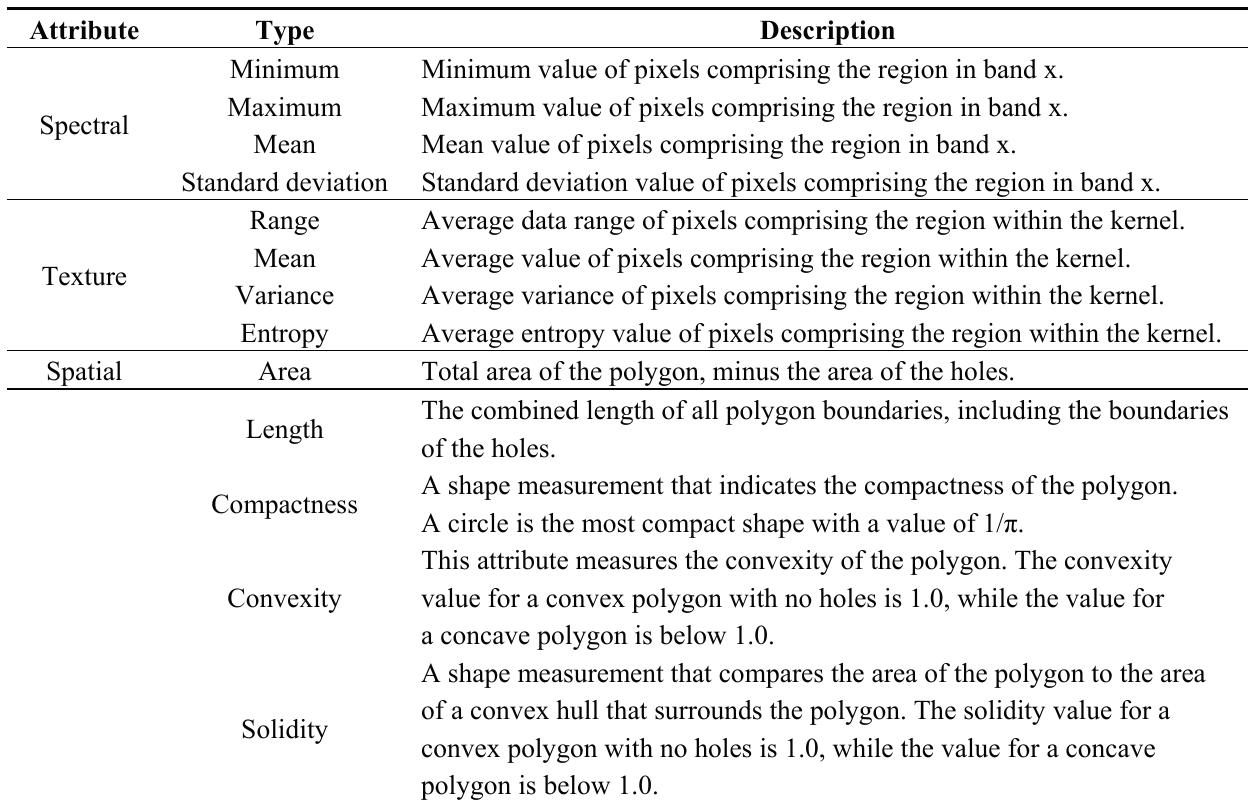
Table 1. Types of attributes computed per segment for the k -NN and SVM classification methods, as implemented in the ENVI 5.0 processing